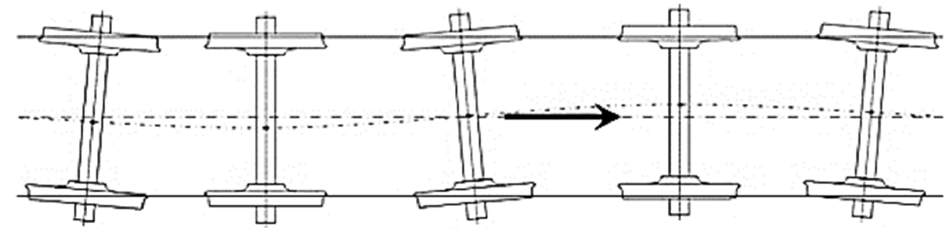
Figure 5. Wheelset oscillation of on the track.